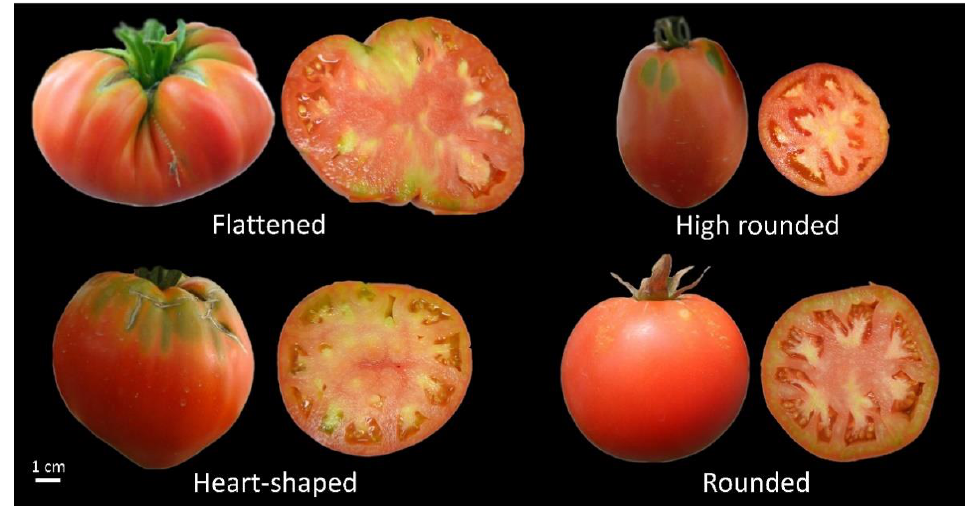
Figure 1. Examples of fruit types (red ripe stage) in the Cypriot tomato landraces panel. All quantitative fruit traits had statistically significant differences across landraces and a probability ranging from p = 0.014 (number of days to flowering) to p < 2.2 × 10 − 16 (number of locules). The number of cavities containing seeds was largely correlated to fruit size and ranged from 5.80 ± 1.03 locules for accession ARI00734 to 13.73 ± 2.46 locules for landrace ARI00906 (Supplementary Figure S1). Additionally, a wide range of variation was established for these characters; the coefficient of variation (CV) was calculated as the ratio of the standard deviation to mean values (Supplementary Table S3). Across traits the highest CV (34.63%) was established for fruit weight. Indeed, fruit weight was a character that largely variated; since in the Cypriot tomato collection there were medium-size fruit genotypes (211.20 ± 75.73 g for ARI00735) and exceptionally large ones (530.00 ± 104.34 g for ARI00737). Pearsons’ correlations, depicted as a heatmap, revealed that several traits were significantly affiliated (Supplementary Figure S2). Fruit weight and width were the two characters that were highly positively associated (r = 0.953, p < 0.01; Sig. 2-tailed), while the number of locules was also correlated to fruit width (r = 0.720, p < 0.05; Sig. 2-tailed) and weight (r = 0.743, p < 0.05; Sig. 2-tailed).